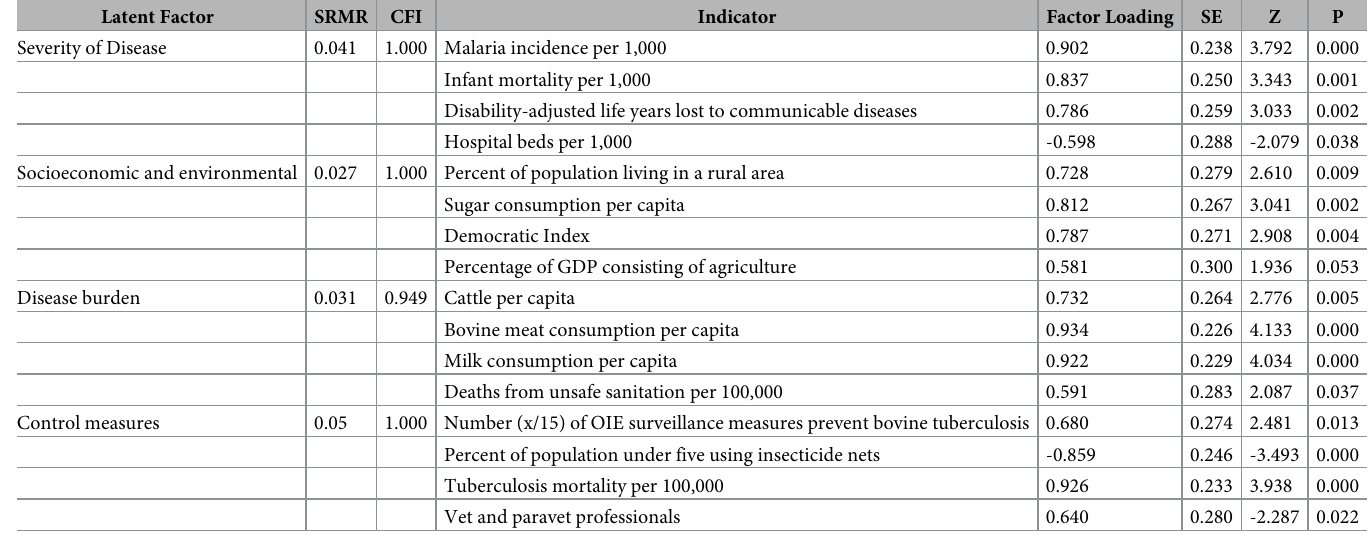
Table 3. Confirmatory factor analysis